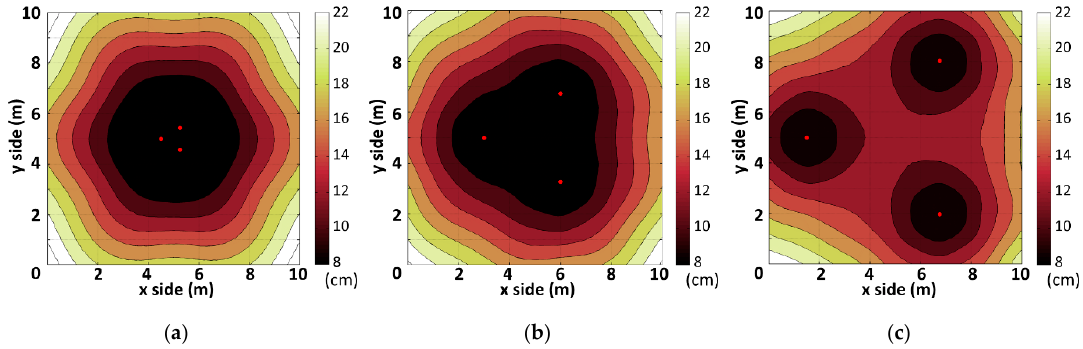
Figure 6. Cramer–Rao lower Bound (CRB) evaluation for triangular mesh at different edge sizes: ( a ) 0.85 m; ( b ) 3.45 m; ( c ) 6 m.